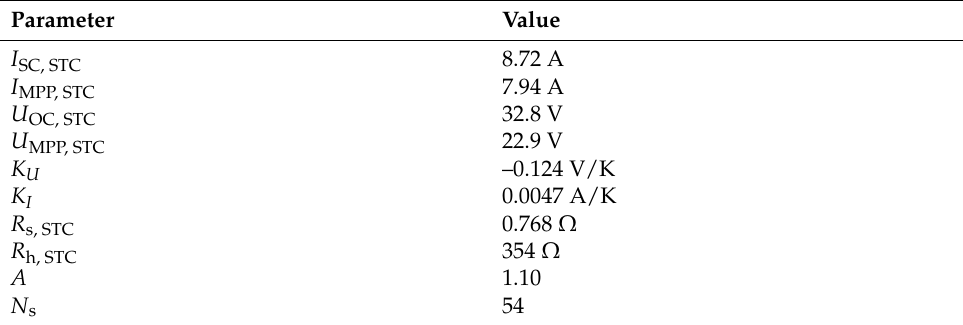
Table 1. The electrical characteristics of the used PV module under